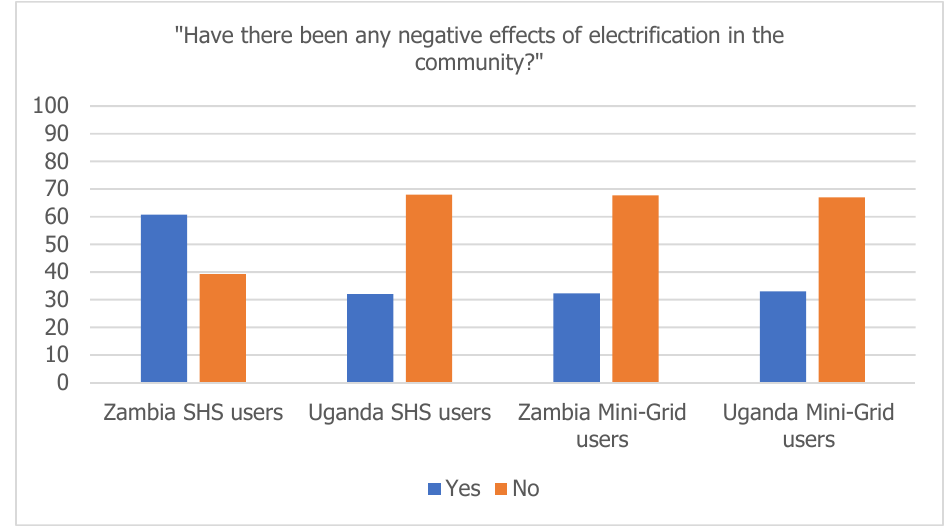
Figure A9. Perceived negative effects of electrification among various subgroups; Responses in %.